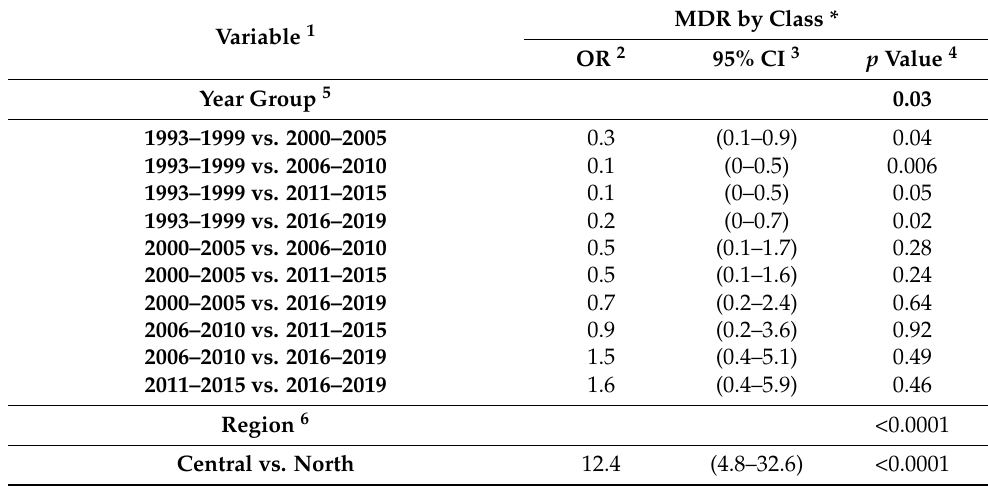
Table 9. Odds ratio for the effect of year group, region and age group for a S. Dublin being classified as multidrug resistant. p values in bold indicate significant odds ratio